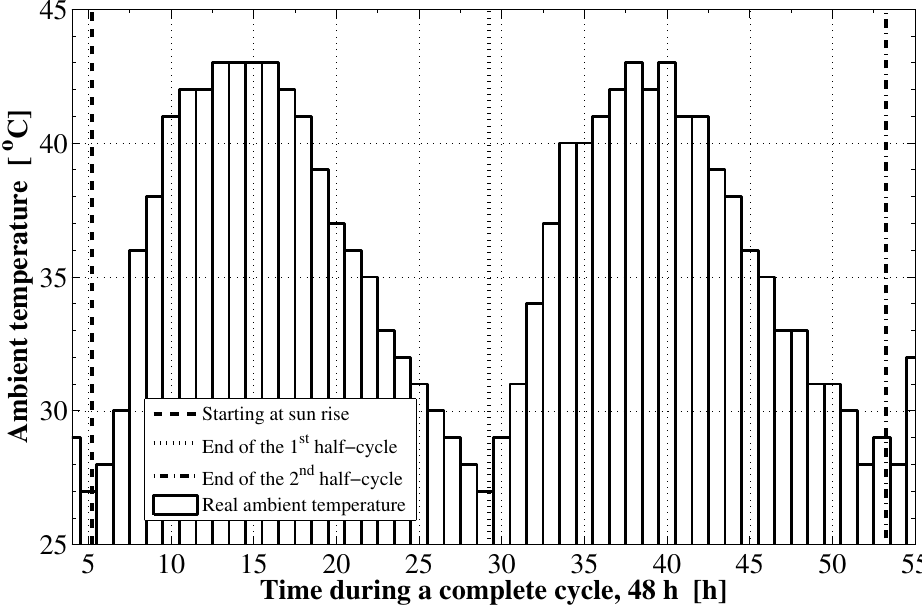
Figure 2. Records of the atmospheric temperature variations during the cycle, as reported by the King Khaled International Airport weather station OERK in Riyadh, 1 July 2013 to 3 July